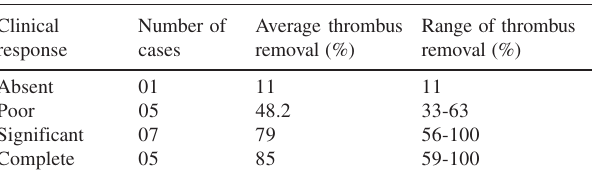
Table 2 - Mean percentage thrombolysis vs acute clinical improvement Clinical